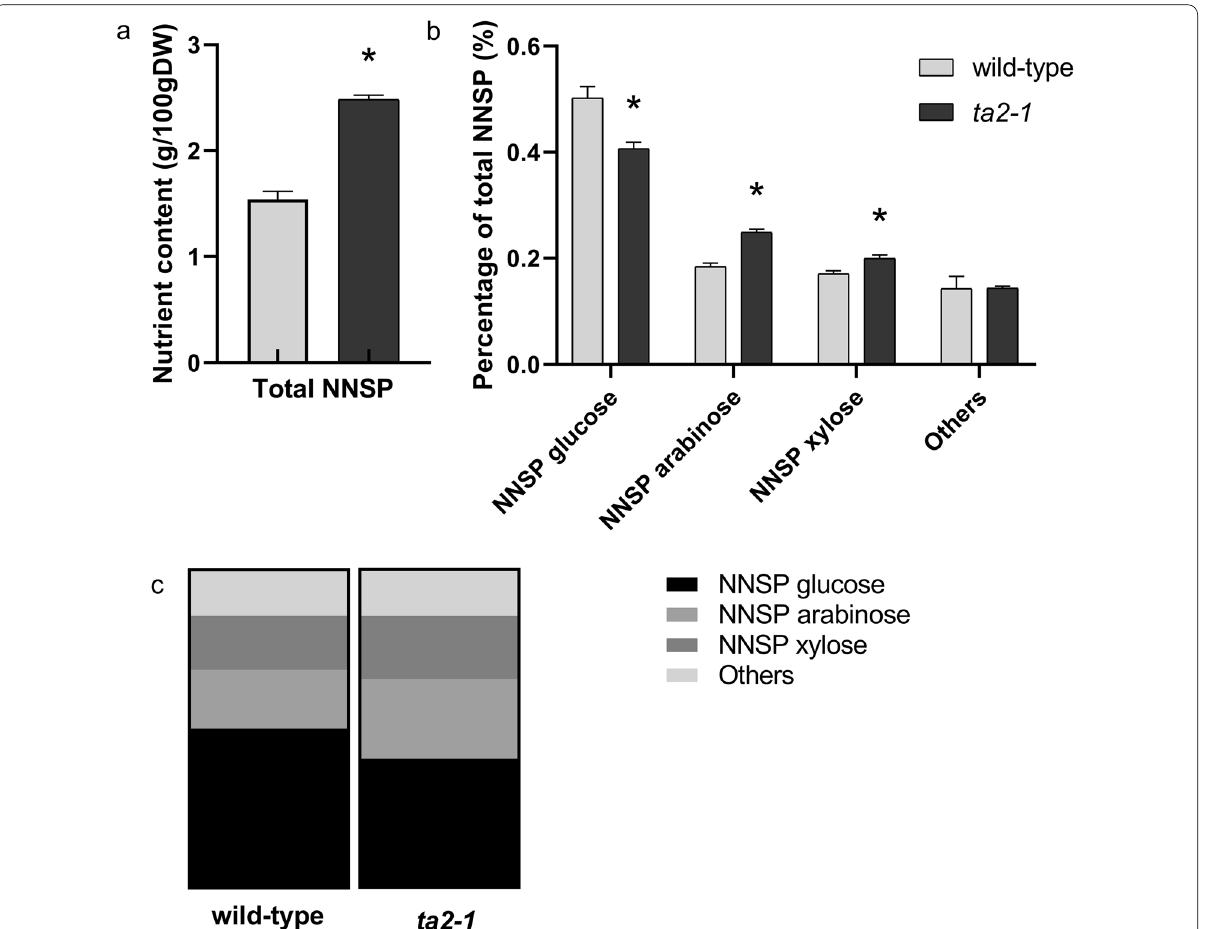
Fig. 6 Comparison of total NNSP and NNSP composition. Comparison of a total NNSP, b NNSP composition of glucose, arabinose, and xylose (* P < 0.05; ANOVA, Tukey’s HSD test), and c NNSP composition in parts of whole format (total NNSP, NNSP glucose, arabinose, and xylose, n